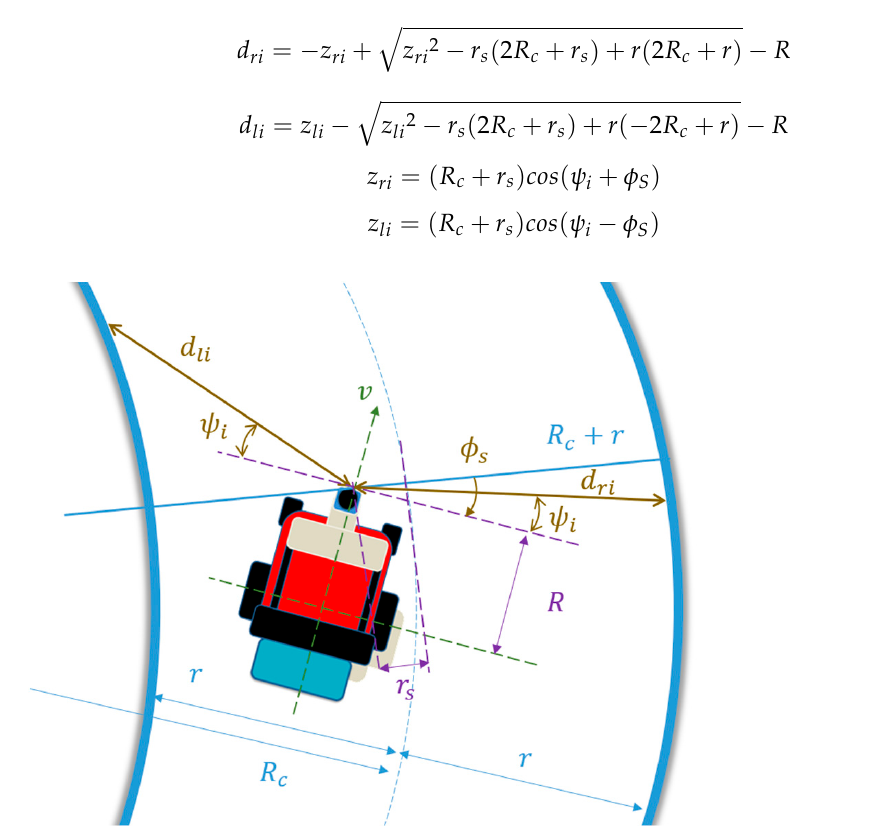
Figure 4. Variables used in the motion dynamics of i E-Wheelchair.